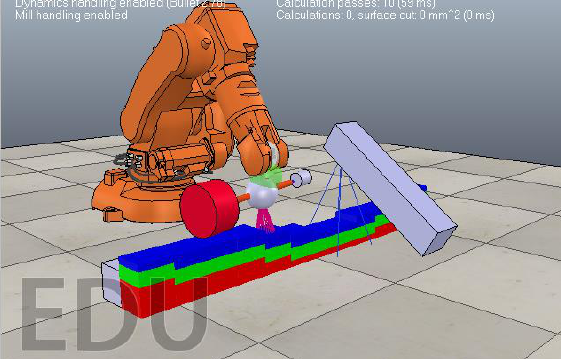
Figure 7. Digital twin particle-based simulation environment consisting of a robot arm. The robot arm is equipped with a rotating end-effector and a depth sensor for sensing the curvature of the digitized fan blade. The blue rectangle box depicts a mobile camera stand that captures the condition of the surface of the fan blade as it is treated.